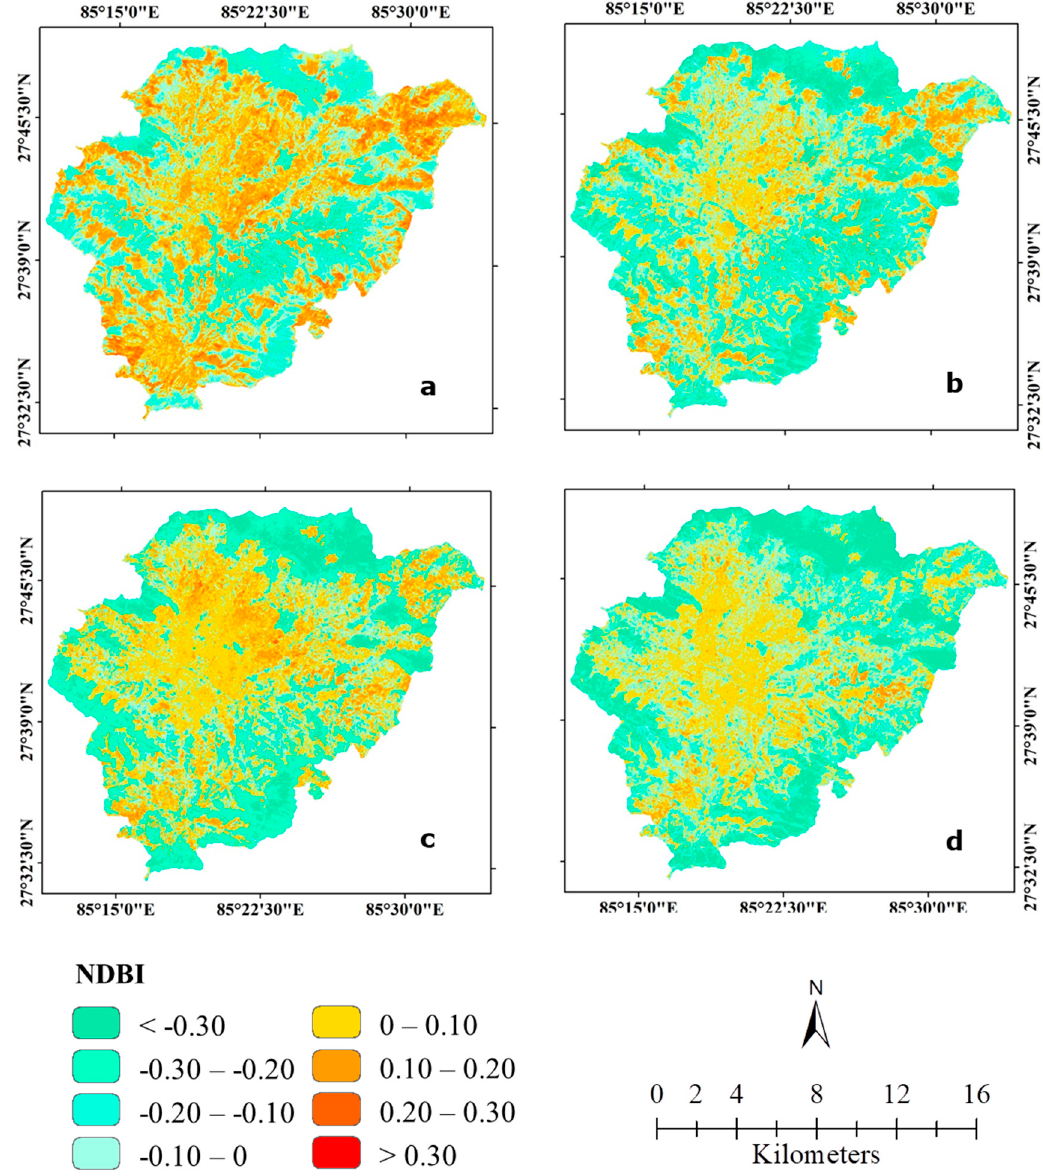
Figure 8. Spatial distribution of Normal Difference Built-up Index (NDBI) in Kathmandu for, ( a ) 1988; ( b ) 1998; ( c ) 2008; ( d ) 2018.